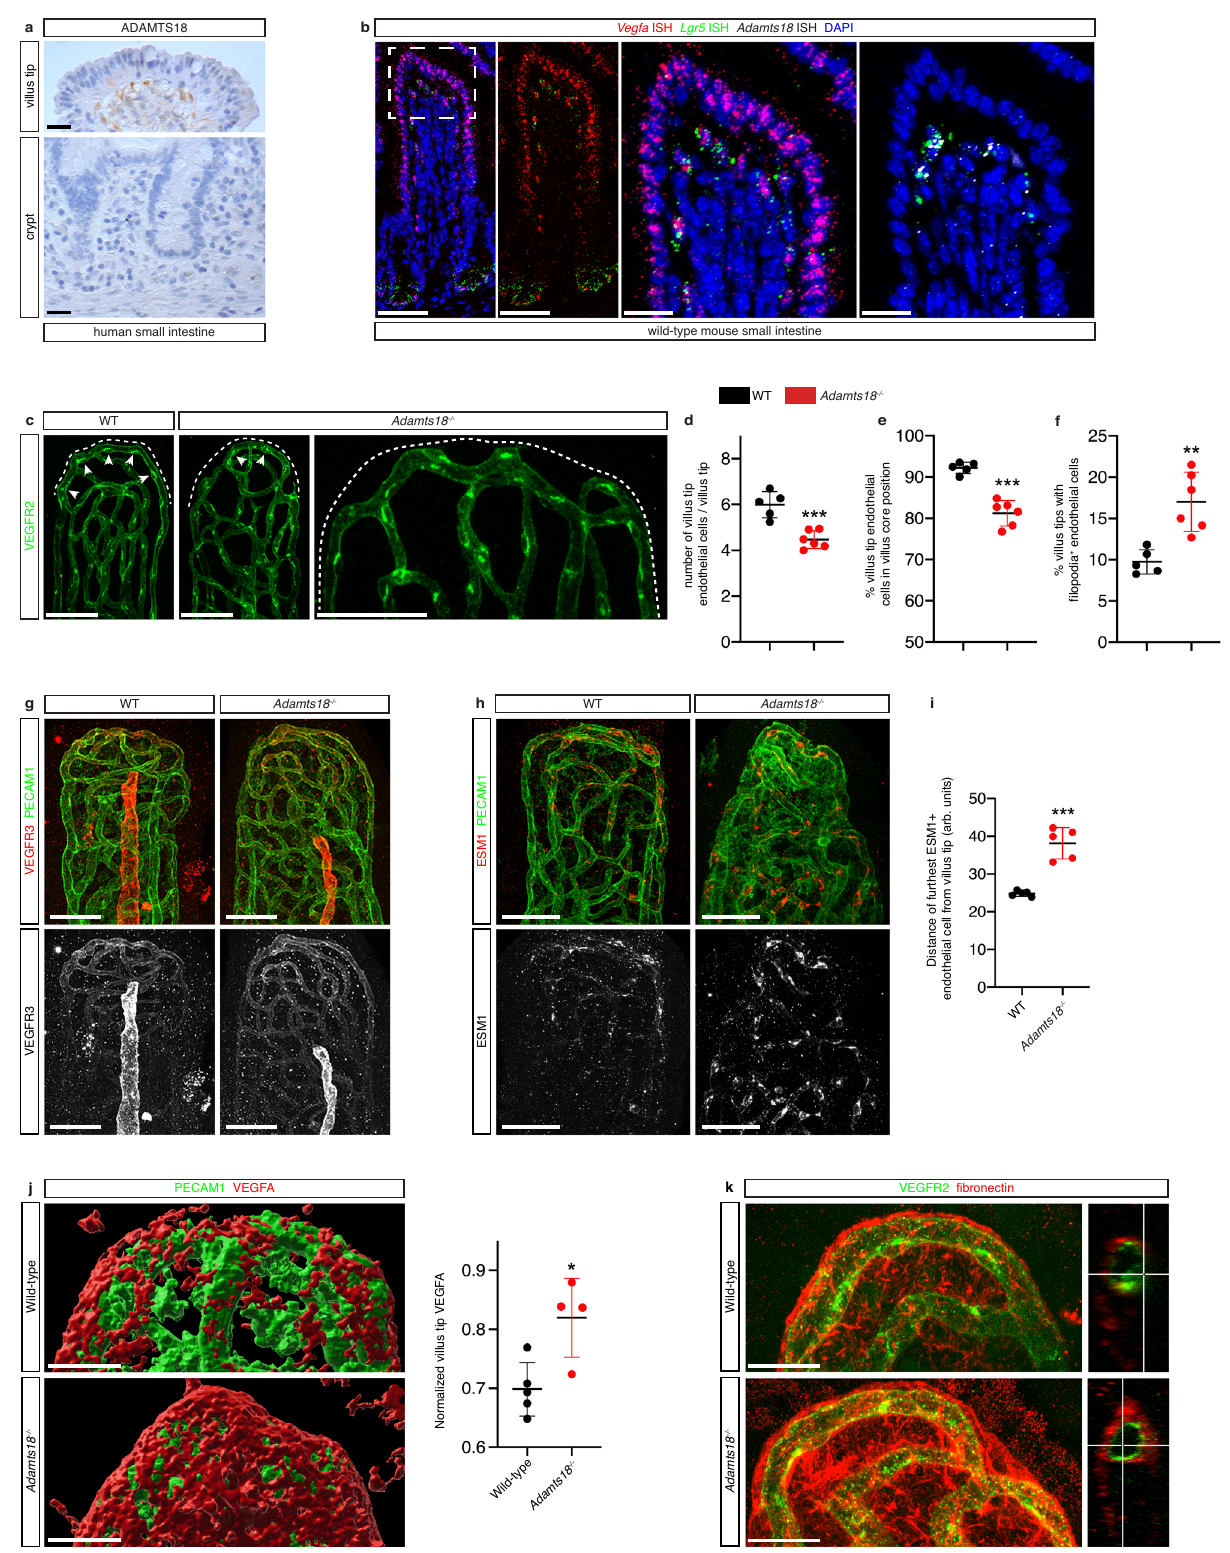
Supplementary Data fi le 4) suggesting that loss of villus tip ADAMTS18 and endothelial polarization does not alter glucose absorption. Although total protein in portal vein serum was similar between control and Adamts18 − / − mice, analysis of unlabeled metabolites indicated that Adamts18 − / − mice have a small,